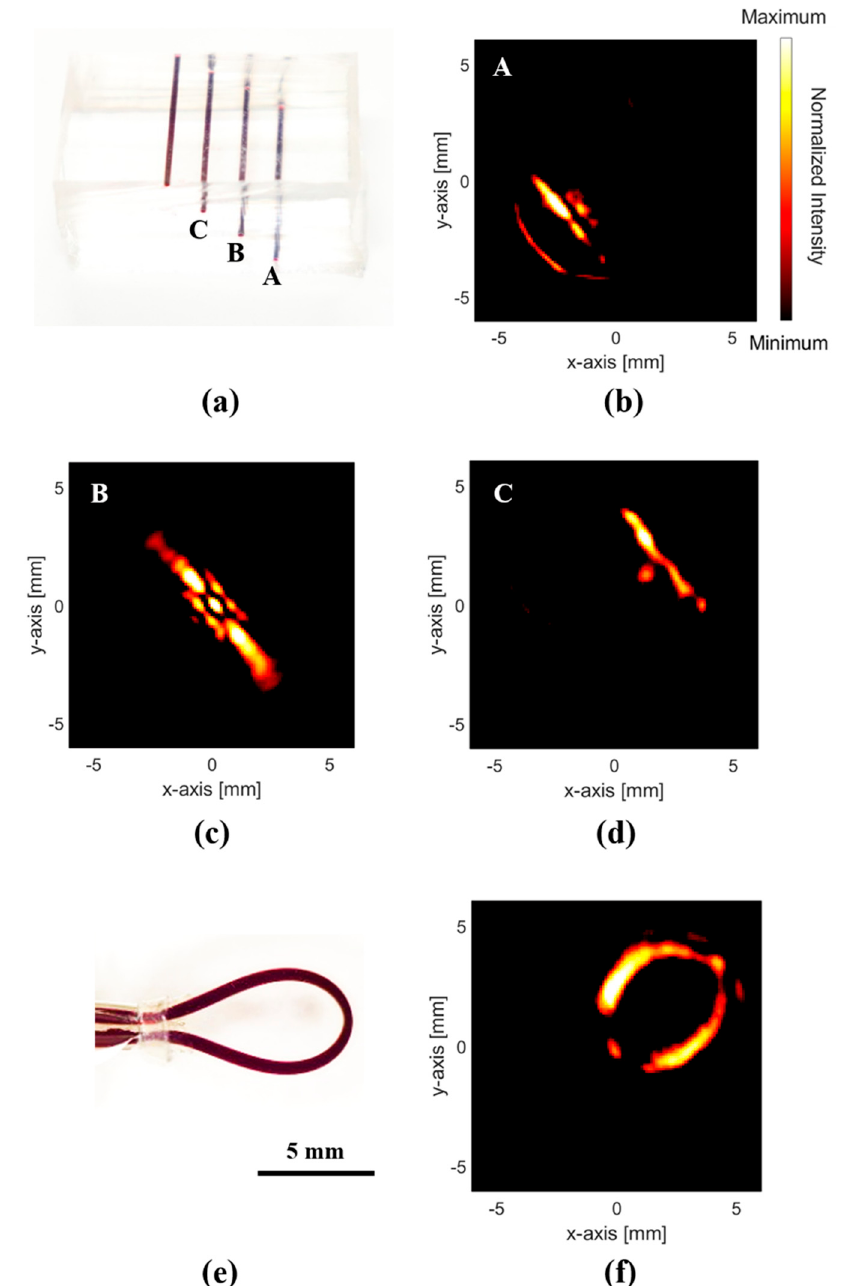
Figure 4. ( a ) Optical images of tube phantoms filled with red ink with different depths and widths. ( b – d ) PA images of near, middle, and far depth tubes, respectively. ( e ) Optical image of curved tube phantom filled with red ink. ( f ) PA image of curved tube in (e).